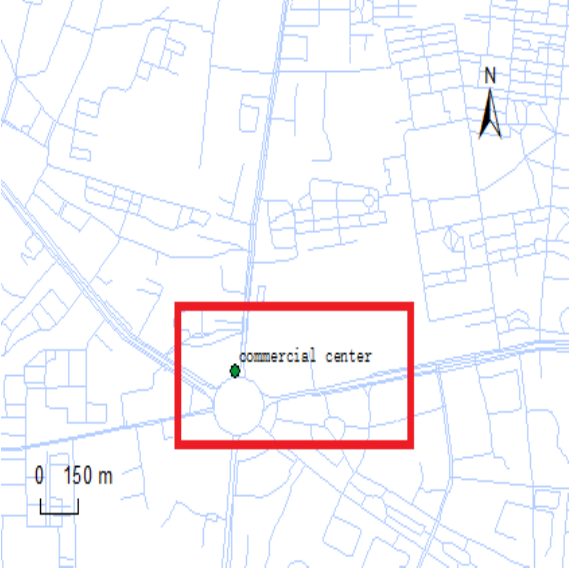
Figure 7. POI expression at 1:15,000